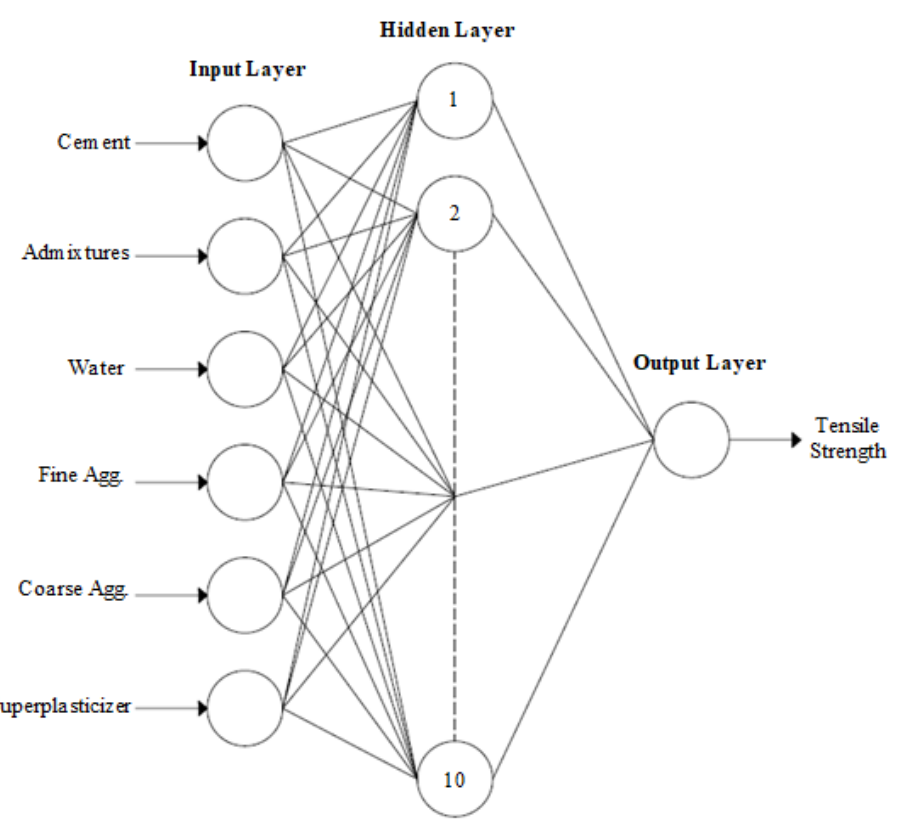
Figure 5. Artificial neural network architecture.